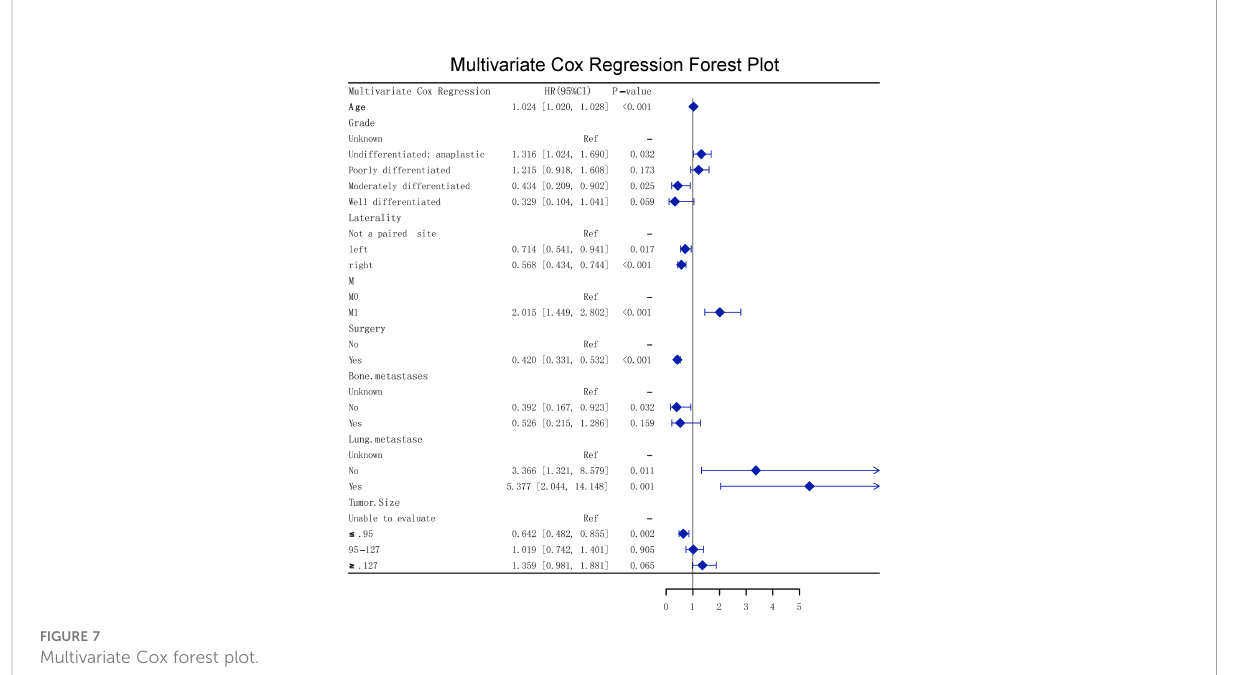
FIGURE 7 Multivariate Cox forest